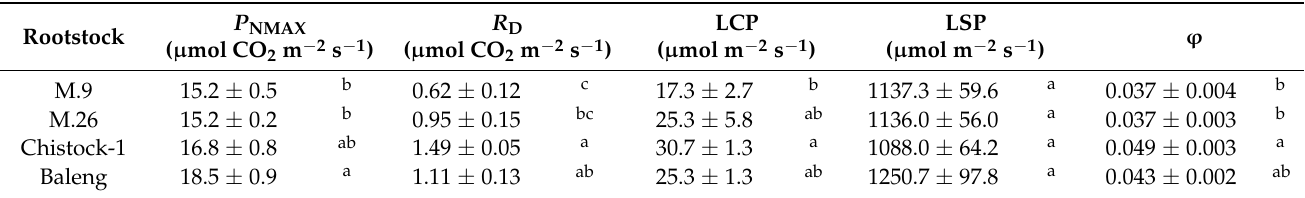
Parameters were measured on the same functional leaves. Data in the table are mean values ( n = 3) ± standard error (SE). Different letters after mean values ± standard error in the same column indicate the significant difference determined by the least significant difference (LSD) test with p < 0.05.